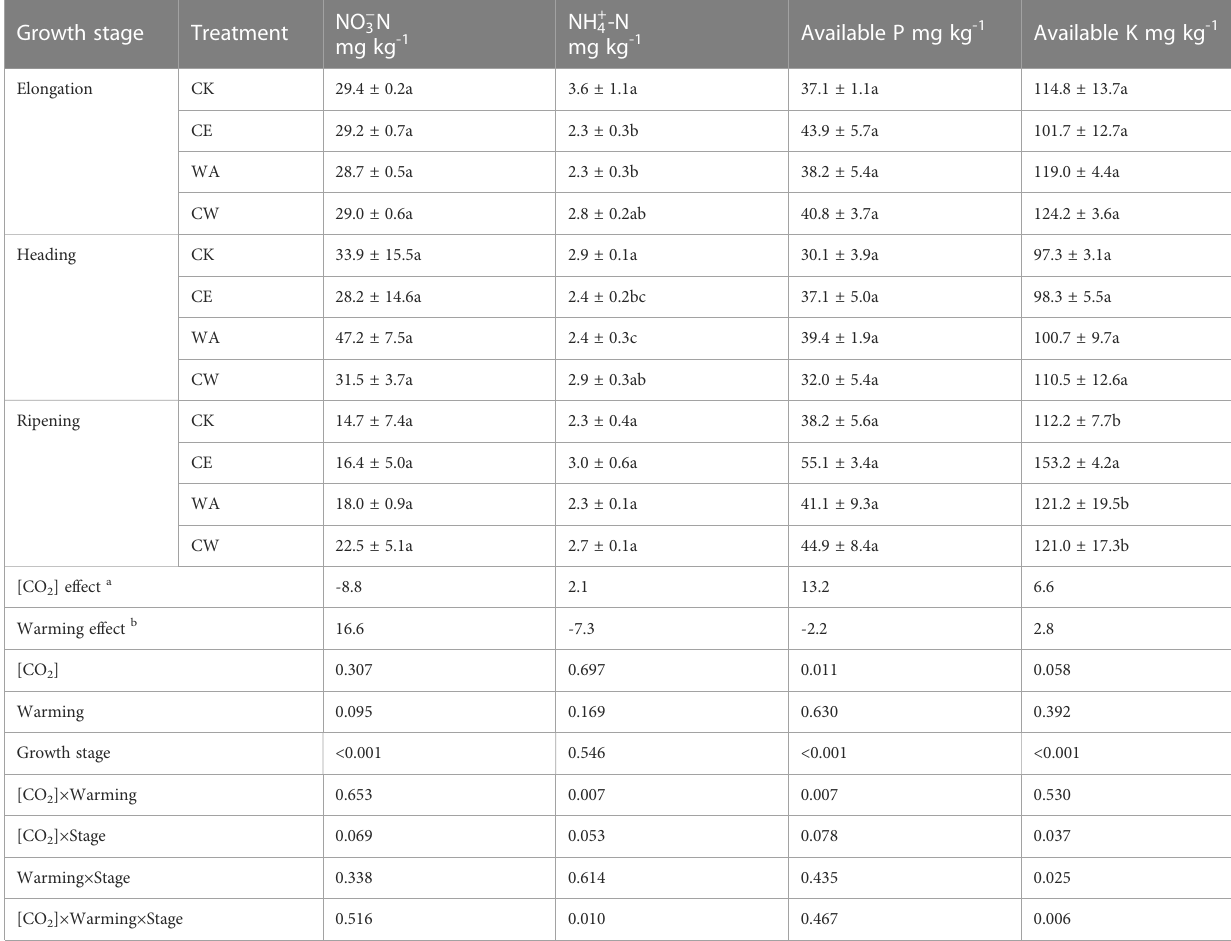
TABLE 3 Soil nutrient status under ambient condition (CK), elevated [CO 2 ] alone (CE), canopy warming alone (WA), and combined treatment (CW).